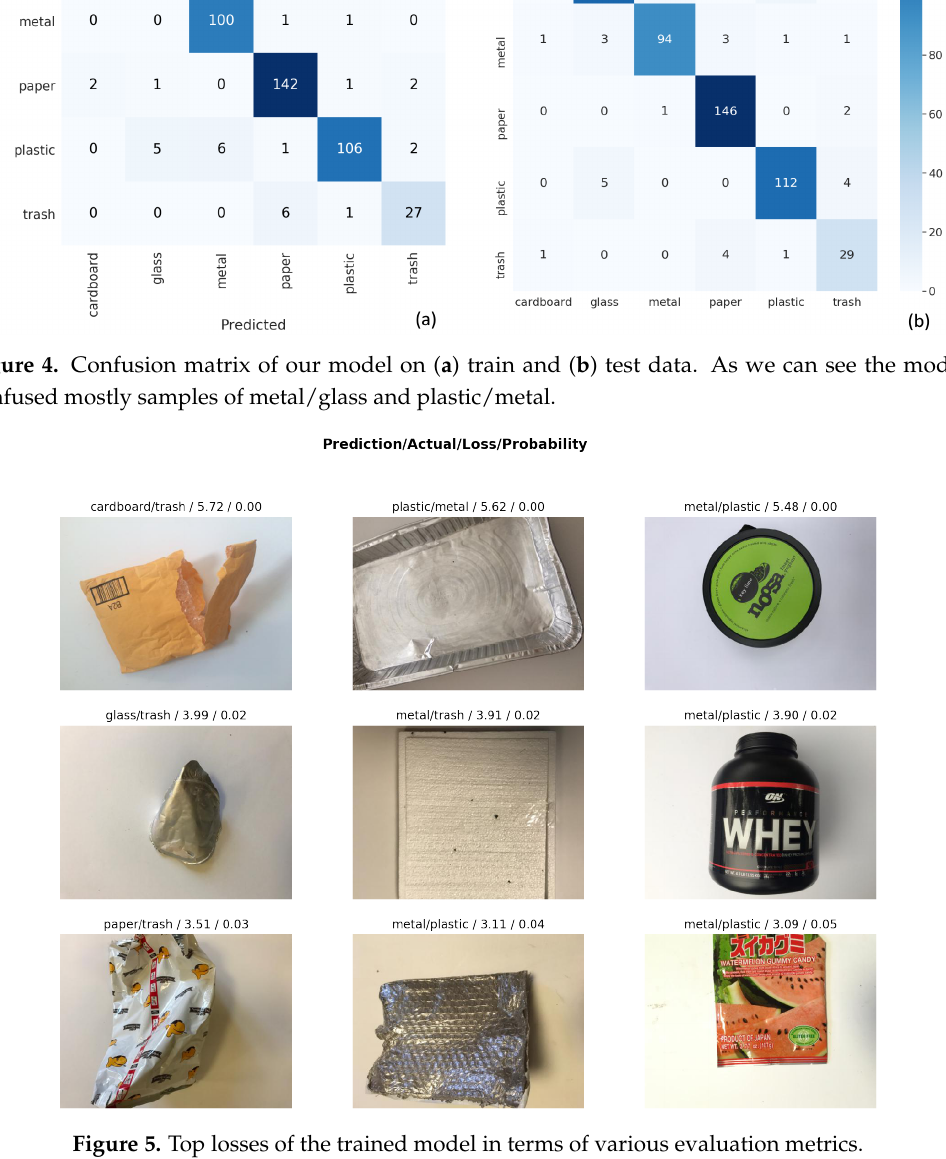
Figure 5. Top losses of the trained model in terms of various evaluation